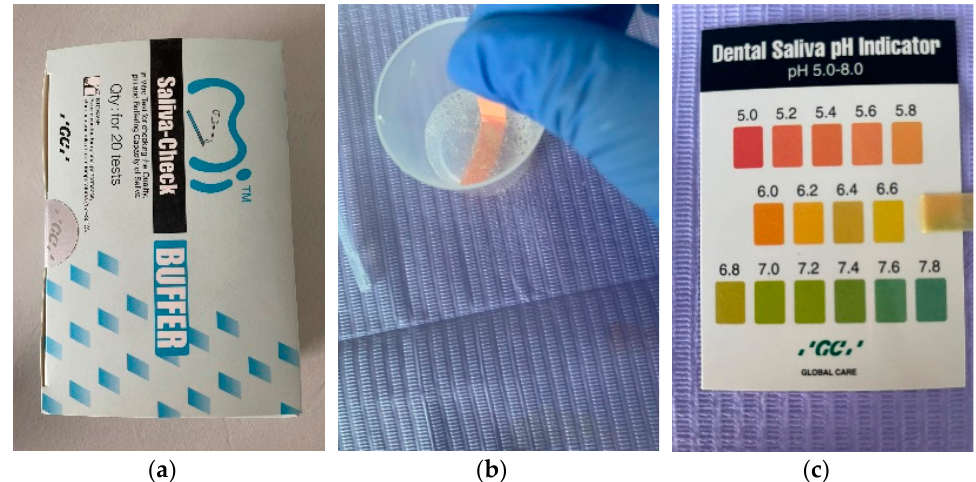
Figure 1. ( a ) GC Saliva Check Buffer kit; ( b ) Placing the pH test strip; ( c ) Obtaining the pH value.